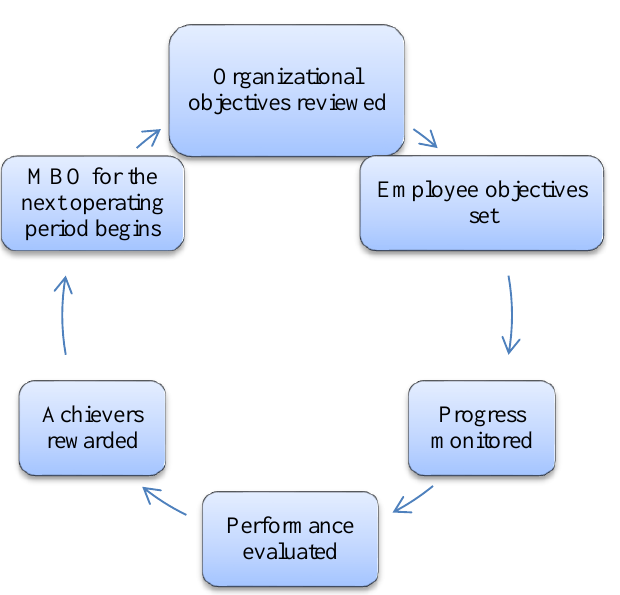
Fig. 1. MBO process steps (Ghicajanu,